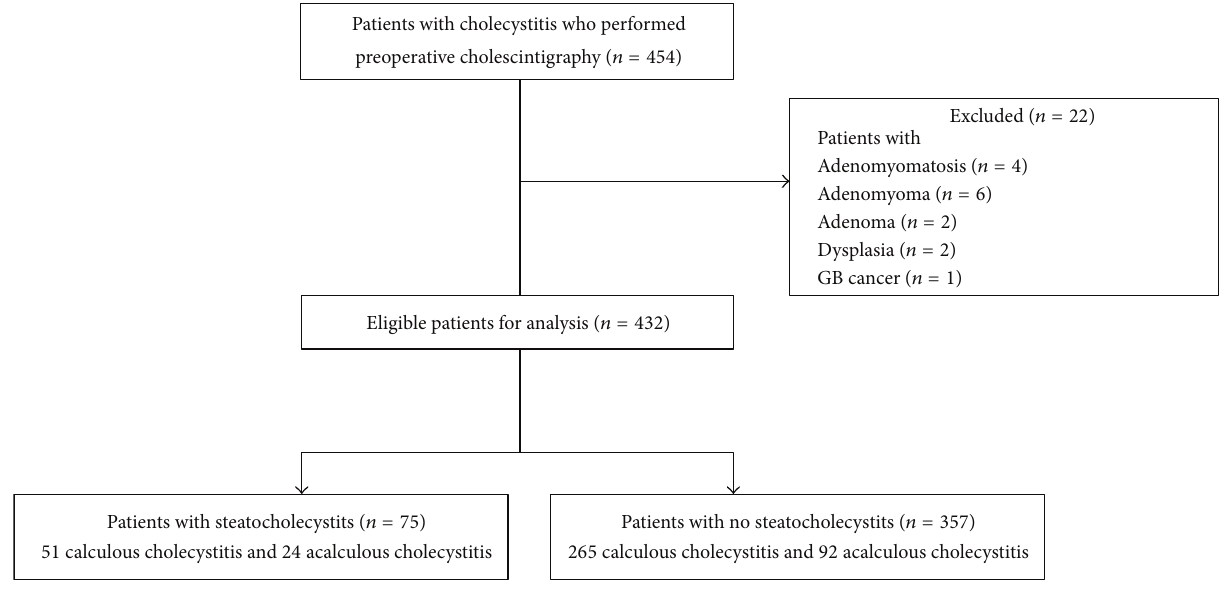
Figure 1: Flow chart of study design. Table 2: Clinical characteristics of patients with